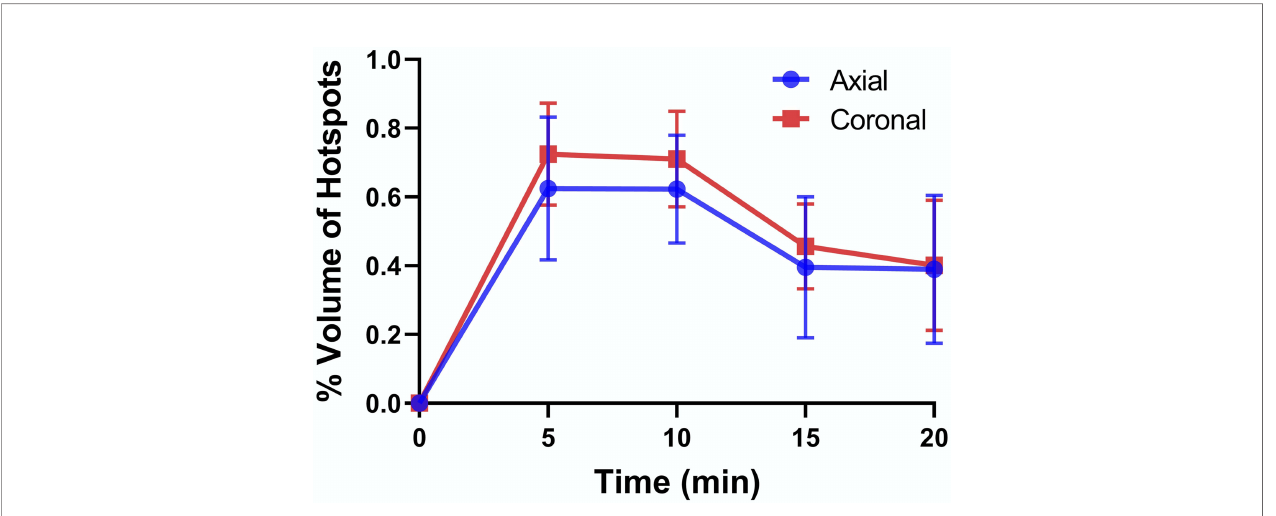
FIGURE 3 | Percent volume of hot spots relative to total volume of the pancreatic tail as detected in axial and coronal slices. The data at each time point are averages ± SD for n =